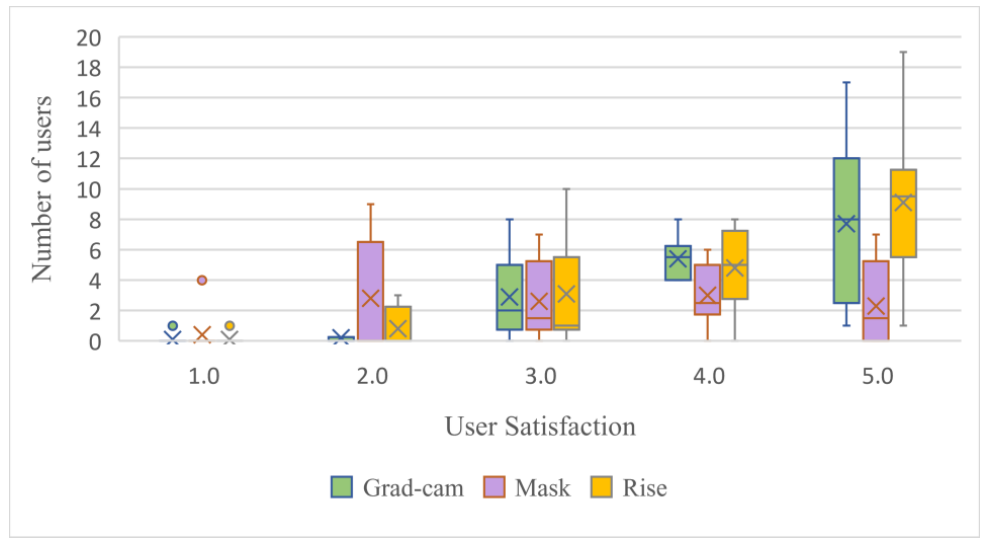
Figure 14. The user satisfaction distribution of different interpretation algorithms under the top-8% occlusion. Each interpretation method is tested with 10 images from DataS and 35 users. Satisfaction score is 1–5 (1 means most dissatisfied, 5 means most satisfied).